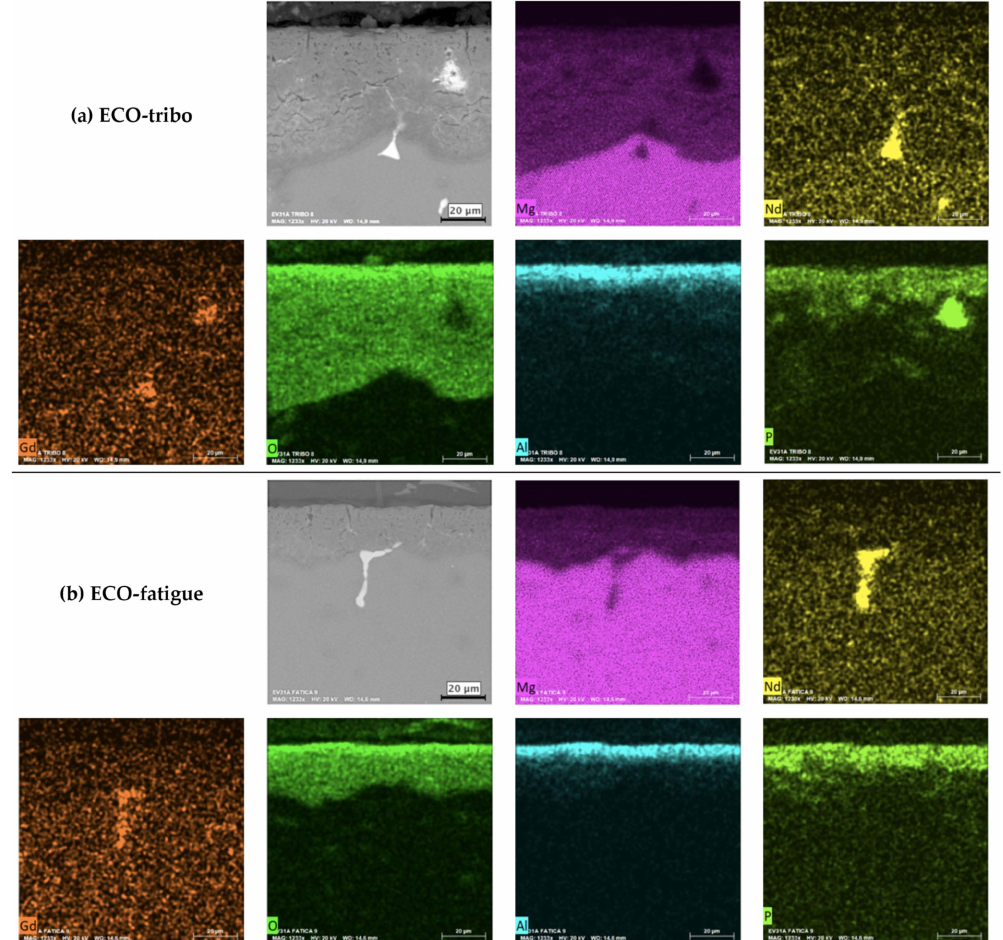
Figure 4. BSE images and EDS X-Ray maps showing elemental distribution in cross section for the ECO layer on cast EV31A-T6: tribological (ECO-tribo) ( a ) and fatigue (ECO-fatigue) samples ( b